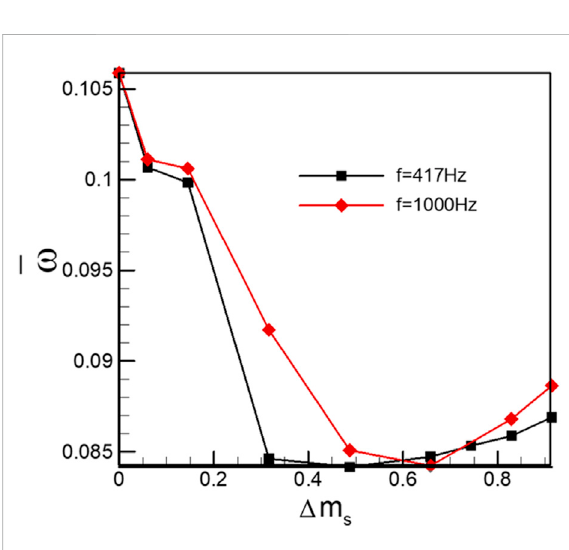
FIGURE 6 Distribution of total pressure loss according to the oscillation amplitude in the control of BLOS (0.39 (cid:1) Z , m s = 1.77%, α = 25 o , i = 0 o